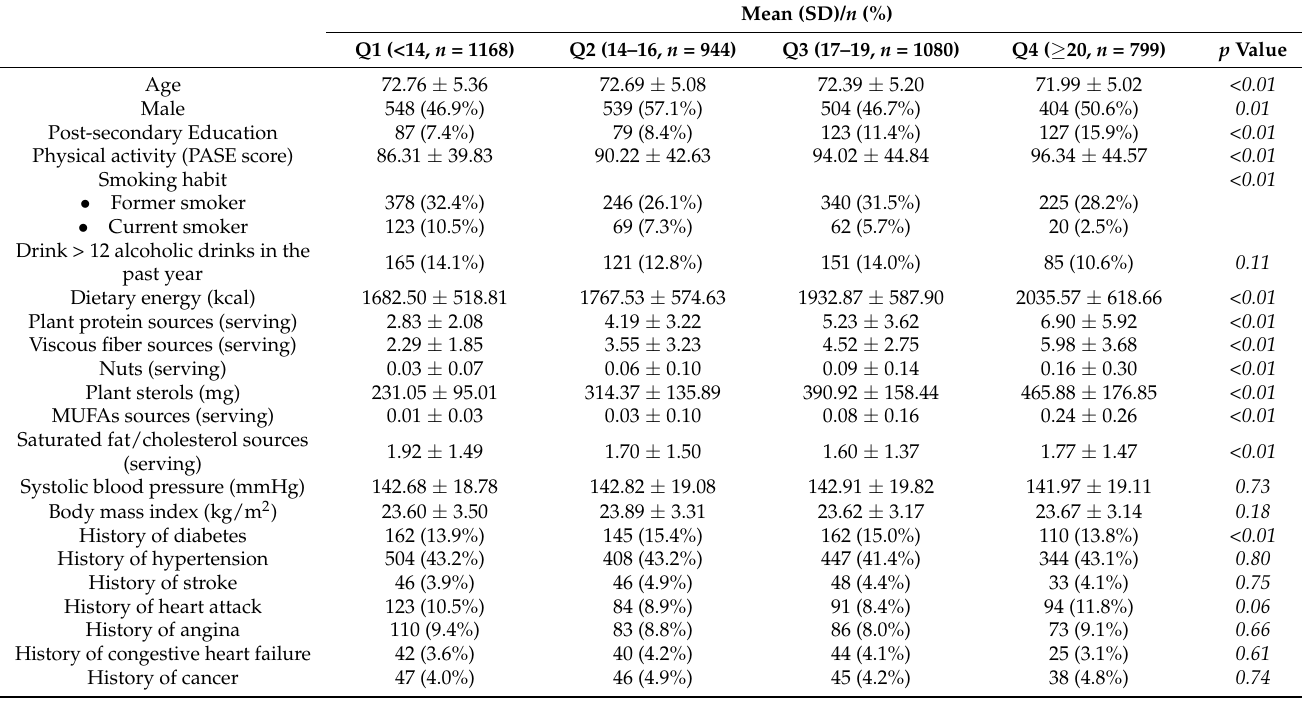
Table 2. Baseline characteristics of participants in Mr. OS and Ms. OS Study by quartiles of Portfolio Diet